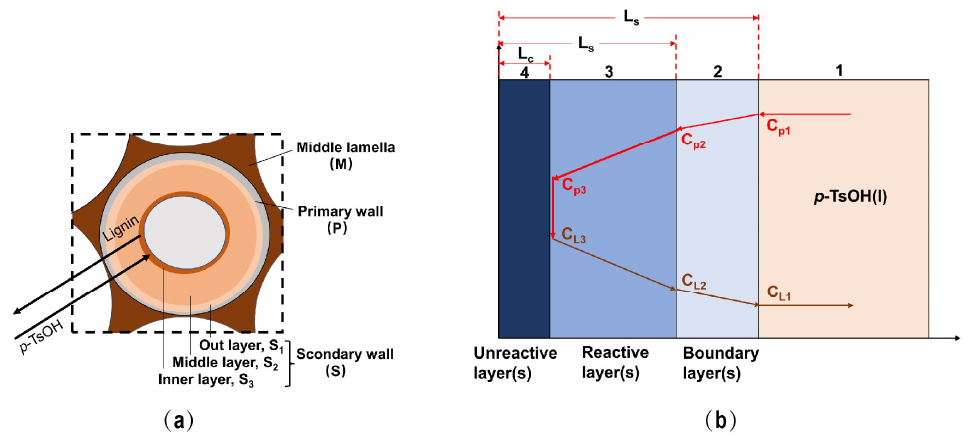
Figure 4. ( a ) Separation of lignin by p -TsOH pretreatment; ( b ) Schematic diagram of the plate core shrinking model.